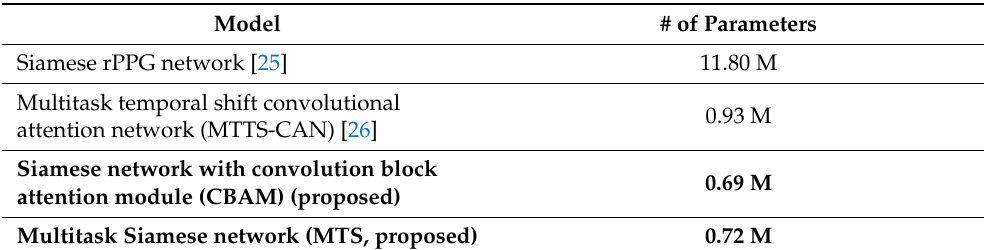
Table 3. The number of parameters of the multitask Siamese network model (MTS) compared with the other models for the predictions of the heart rates and respiration rates.